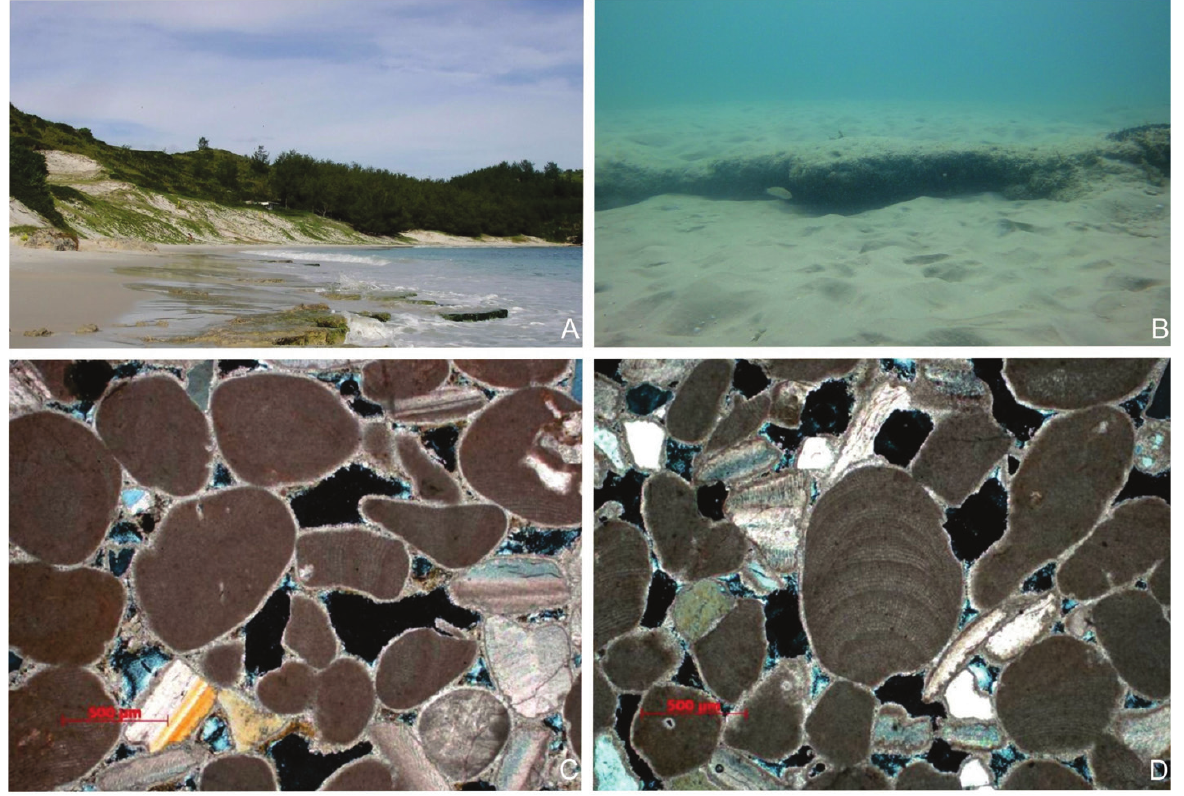
Figure 3 - Occurrence of beachrocks on Cabo Frio Island, southeastern Brazil. A: Beachrocks on the beach surface, at 0.0